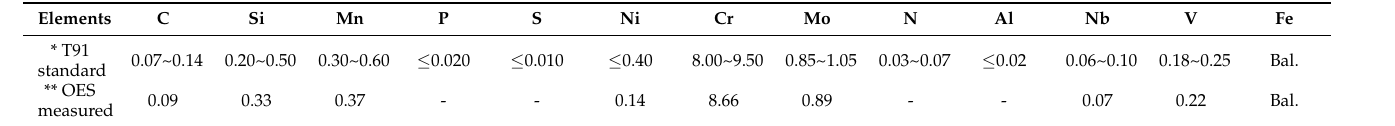
Table 2. Nominal and measured chemical composition (wt. %) of the